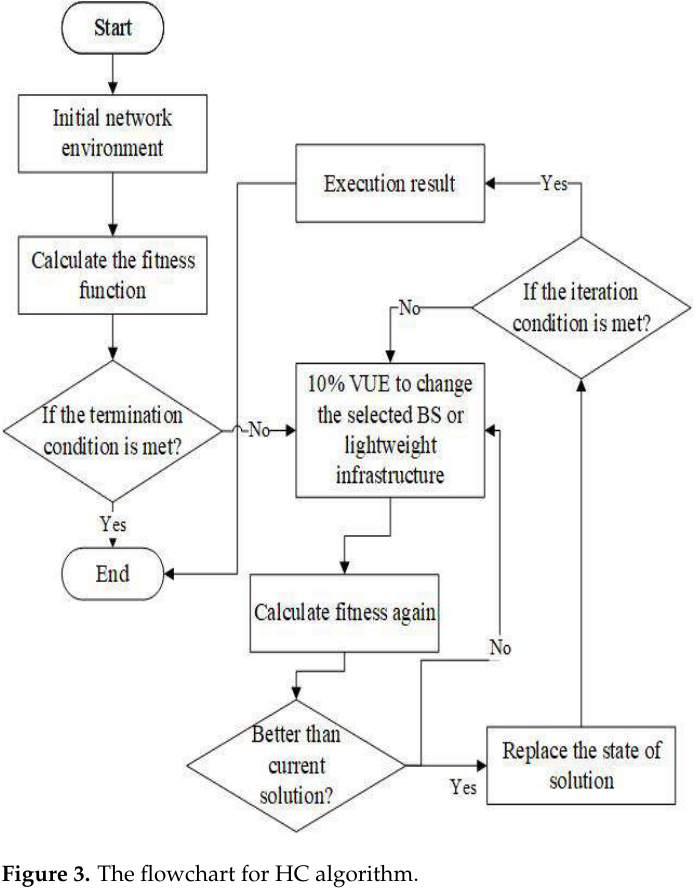
Figure 3. The flowchart for HC algorithm.